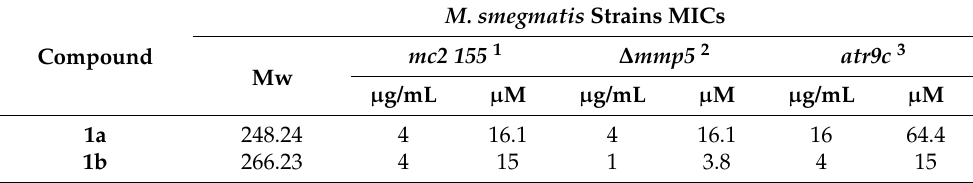
Table 1. MICs of 1a and 1b on M. smegmatis